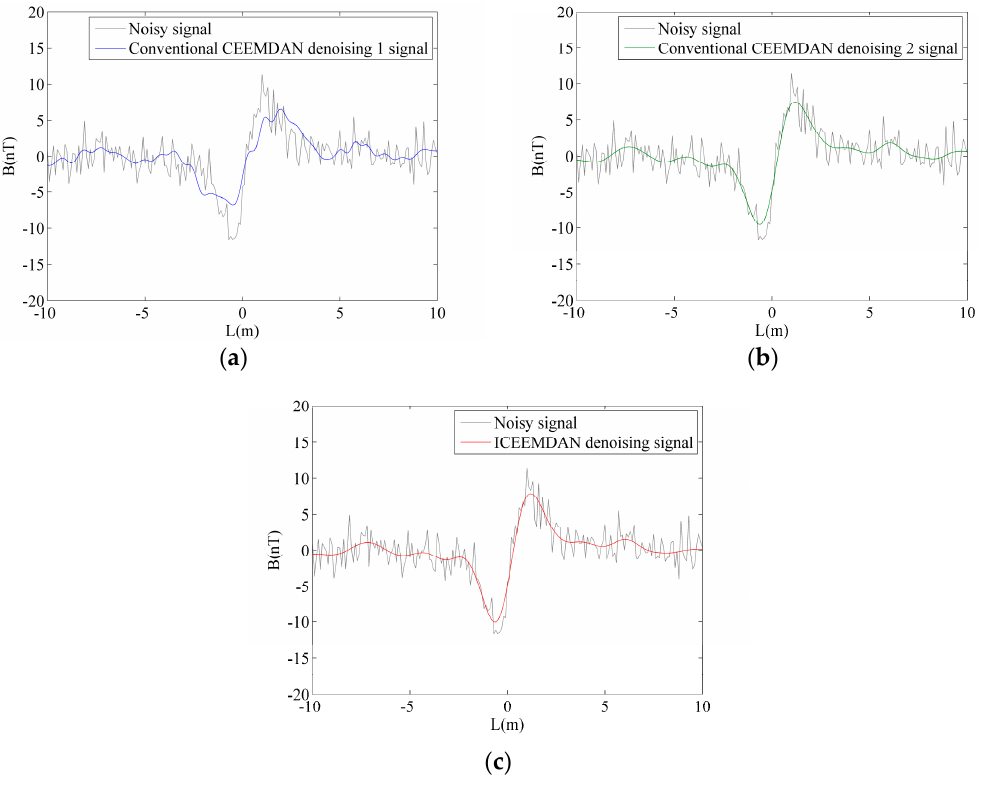
Figure 5. The noisy signal and three denoised signals. ( a ) Conventional CEEMDAN denoising 1. ( b ) Conventional CEEMDAN denoising 2. ( c ) ICEEMDAN denoising. Table 1. Signal-to-noise ratio (SNR) and root mean square error (RMSE) of the three denoising methods. Conventional CEEMDAN Conventional CEEMDAN Indexes ICEEMDAN Denoising Denoising 1 Denoising 2 SNR (dB) 6.0102 RMSE